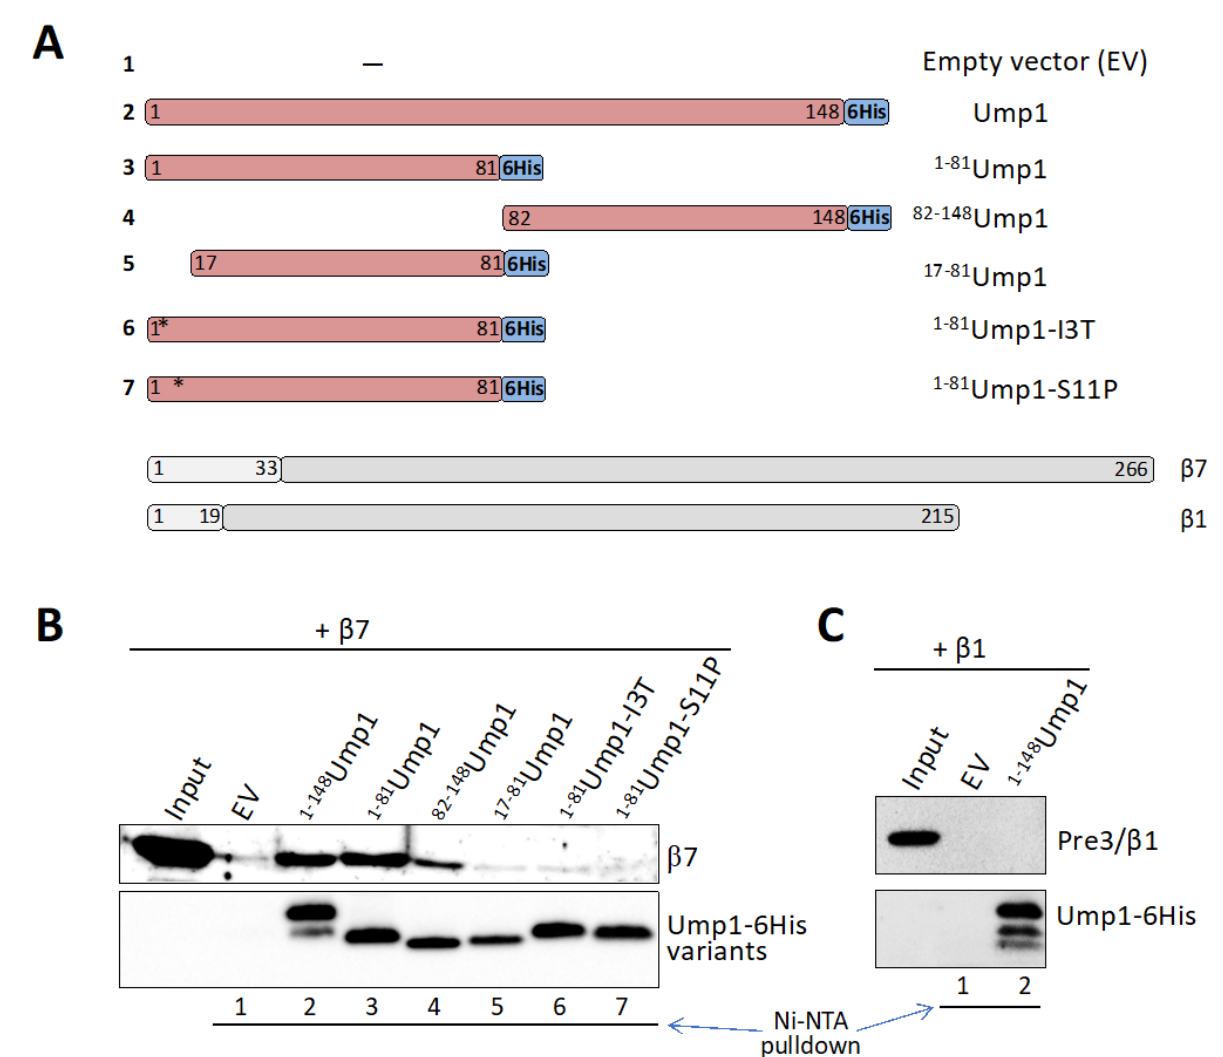
Figure 3. Ump1 N-terminal domain interacts with β 7 subunit in vitro. ( A ) Schematic representation of constructs expressed in E. coli. Ump1 polypeptides were C-terminally tagged with 6His. β 1 and β 7 were initially expressed as fusions to 8His-SUMO1 (not shown) and later, after cleaving off SUMO1, obtained in an untagged form. Positions of the point mutations I3T and S11P are indicated by stars. ( B ) Interaction of the different Ump1 polypeptides with recombinant full-length β 7. Ni-NTA beads were first loaded with Ump1 variants purified from E. coli extracts. A mock purification from an empty vector (EV) transformant extract served as a control. Loaded beads were then incubated with full-length β 7. After washing, bound proteins were eluted with imidazole and analyzed by SDS-PAGE and anti- β 7 and anti-6His Western blotting. The numbers at the bottom refer to the constructs represented in ( A ). ( C ) Interaction assay as in ( B ) but between β 1 and full-length Ump1. We next asked whether the propeptide-dependent interaction of β 7 involved the above-mentioned N-terminal domain of Ump1. To address this question, we shifted to a modified version of the binding assay. Full-length Ump1-6His or 17–148 Ump1-6His